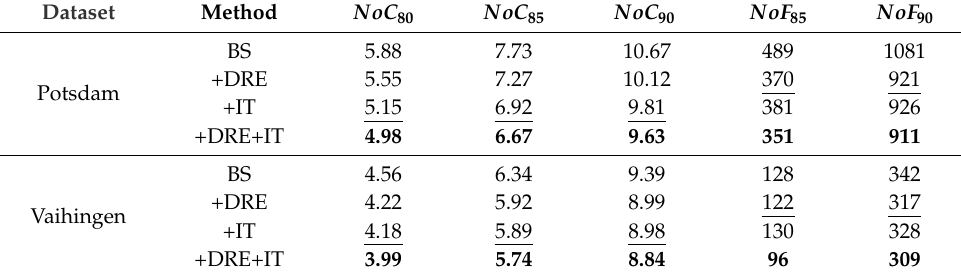
Figure 13. Visualization of the interaction process for FocalClick [24], RITM [22], and our method. The green and red points stand for positive and negative clicks, respectively. The clicks were generated according to the rules described in Section 4.2, and their coding radii are presented. We changed the colors of ground-truth masks (cars and surfaces) to show them clearly. The images in the red block show the CG deterioration problem. The abbreviation “1pc, 2nc” indicates one positive and two negative clicks in the white block. Our method achieved high accuracy earlier while ensuring the CG of the network. Table 6. RoC ablation results for the Potsdam and Vaihingen datasets. The abbreviations “BS” and “IT” indicate the baseline and incremental training strategy, respectively. (The best is bolded and the runner-up is